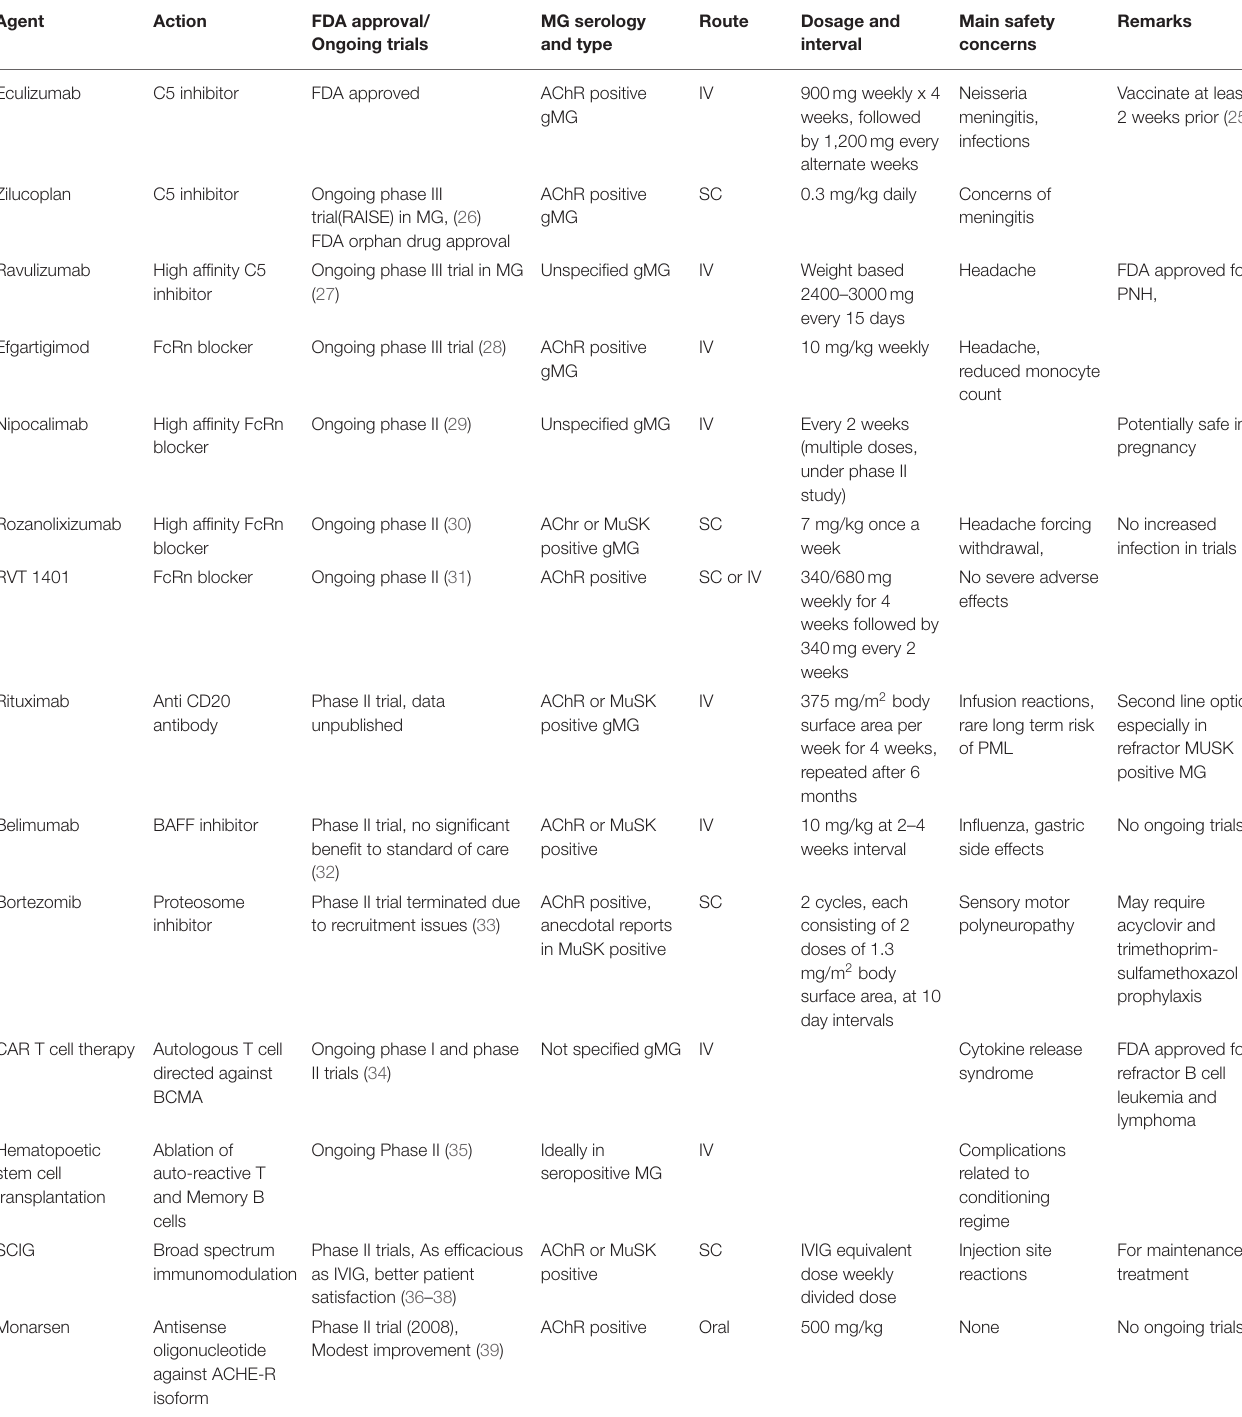
TABLE 1 | Novel immune therapies for treatment of myasthenia gravis. Agent